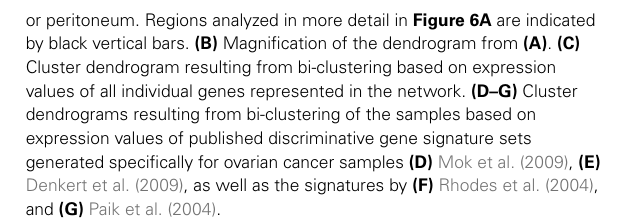
FIGURE 5 | Hierarchical clustering of an ovarian cancer sample data set . (A) Heatmap representation of a complete linkage hierarchical bi-clustering of network module activity, based on expression data of 278 ovarian cancer samples derived from theTothill et al. (2008) data set; the resulting sample distribution dendrogram is annotated according to the clinical sample annotation using the color code as indicated in the legend; labelings are from top to down: labeling 4, consolidated tumor grade; labeling 3, stage code low (I and II) or high (III and IV); labeling 2, cancer type LMP or malignant; labeling 1, primary tumor site ovary, fallopian tube,